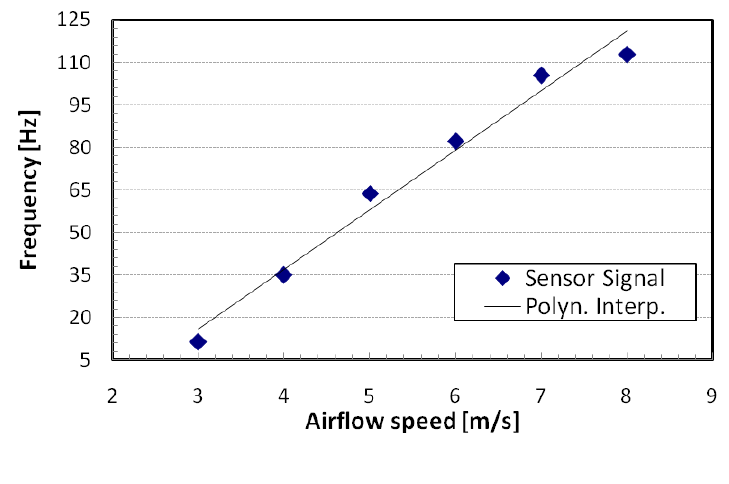
Figure 14. Characterization of the rotor frequency with different airflow